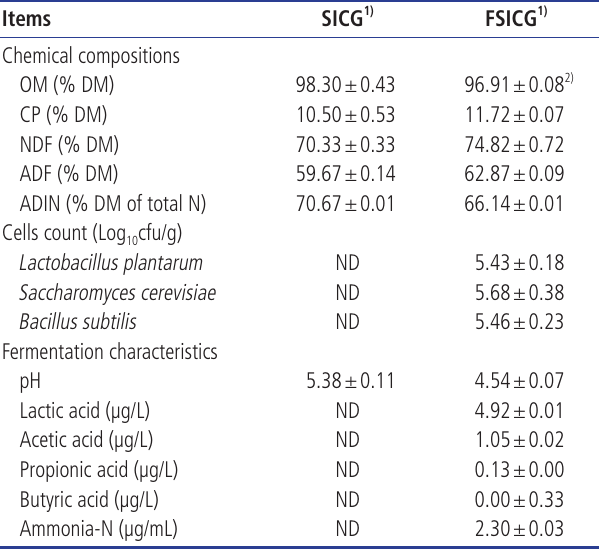
Table 2. Chemical composition of fermented spent instant coffee grounds after 14 days fermentation Items